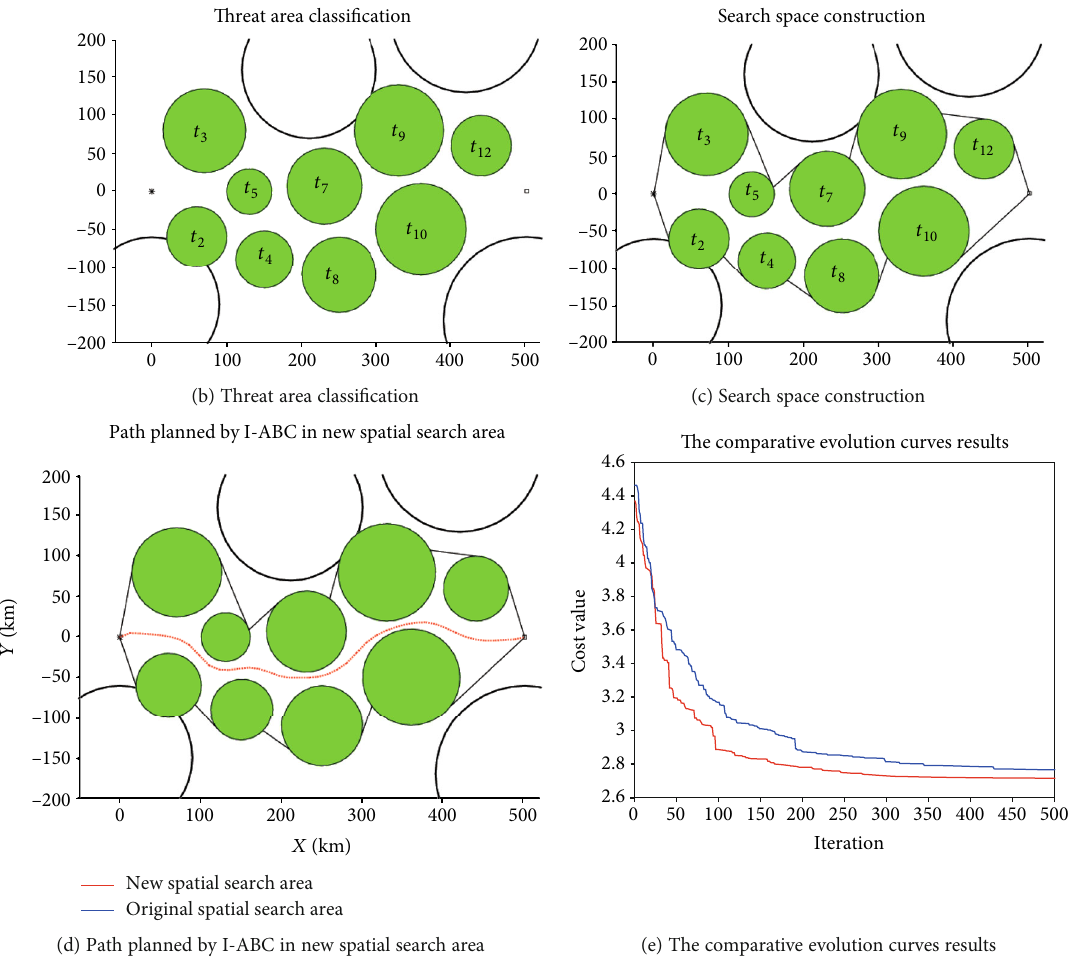
Figure 25: The planning results by I-ABC for the two di ff erent spatial search